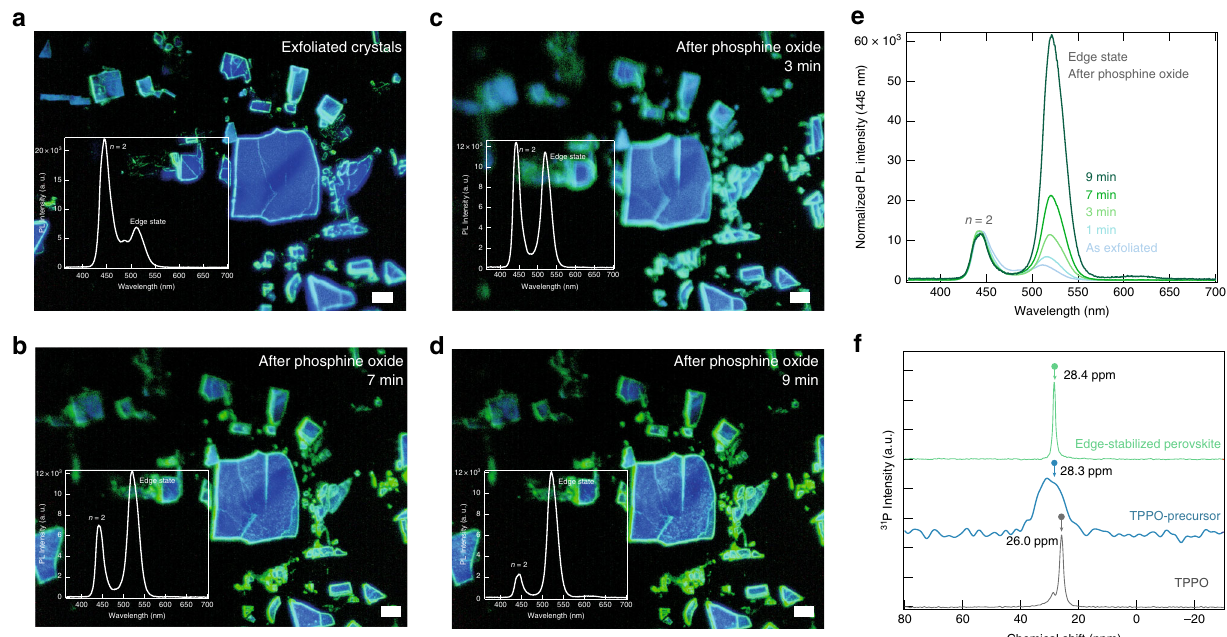
Fig. 4 Origins of edge stabilization. a Microscopic image of the mechanically exfoliated PEA 2 CsPb 2 Br 7 ( n = 2) single crystal under continuous excitation by using a 374-nm laser diode. The inset shows PL spectra, from the both intrinsic ( λ em = 450 nm) and edge state ( λ em = 510 nm) emission. Scale bar is 10 μ m. b – d Microscopic images as function of time after in situ addition of TPPO solution. e Normalized PL spectra extracted from the microscope images. Scale bar is 10 μ m. f 31 P-NMR spectra of TPPO only, TPPO-precursor (TPPO-PbBr 2 ) and TPPO-perovskites to monitor the interaction between P = O and Pb in